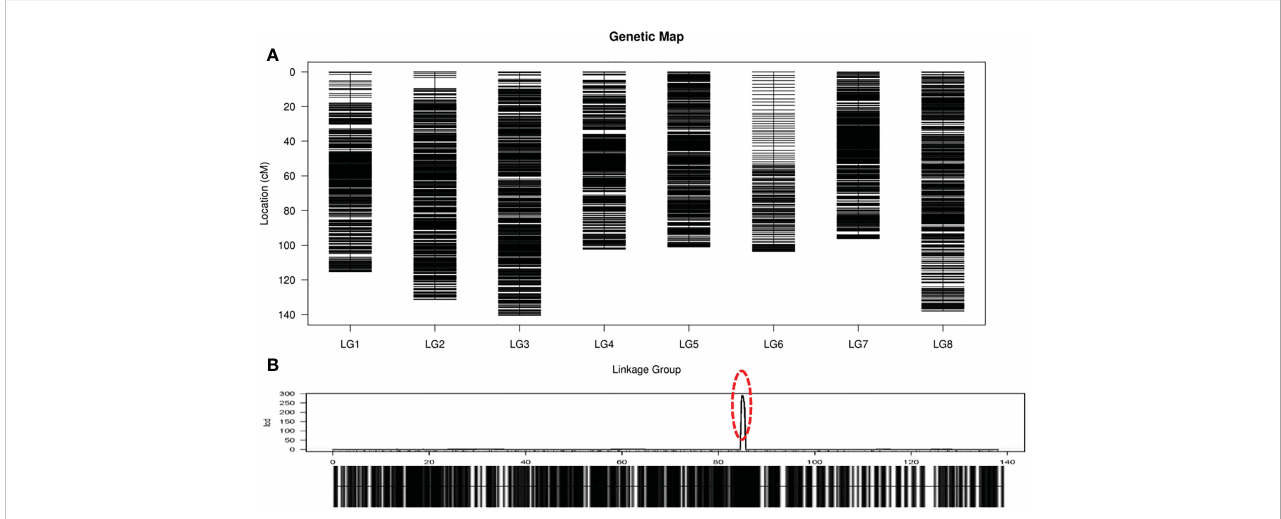
FIGURE 3 High-resolution genetic map of onion. (A) Genetic linkage map of onion. The black bars on each linkage group represent SLAF markers on the map; (B) Locations of male-fertile trait on genetic map. The red circle indicates the site of male-fertile